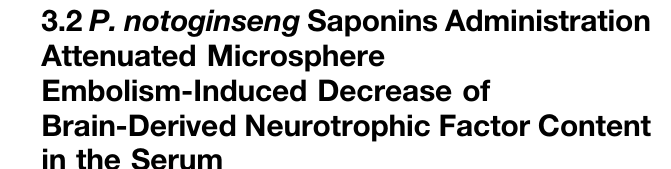
after surgery, PNS 15, 30, 60, 120, and 240 mg/kg signi fi cantly 15 and 60 mg/kg signi fi cantly increased the weight percentage.